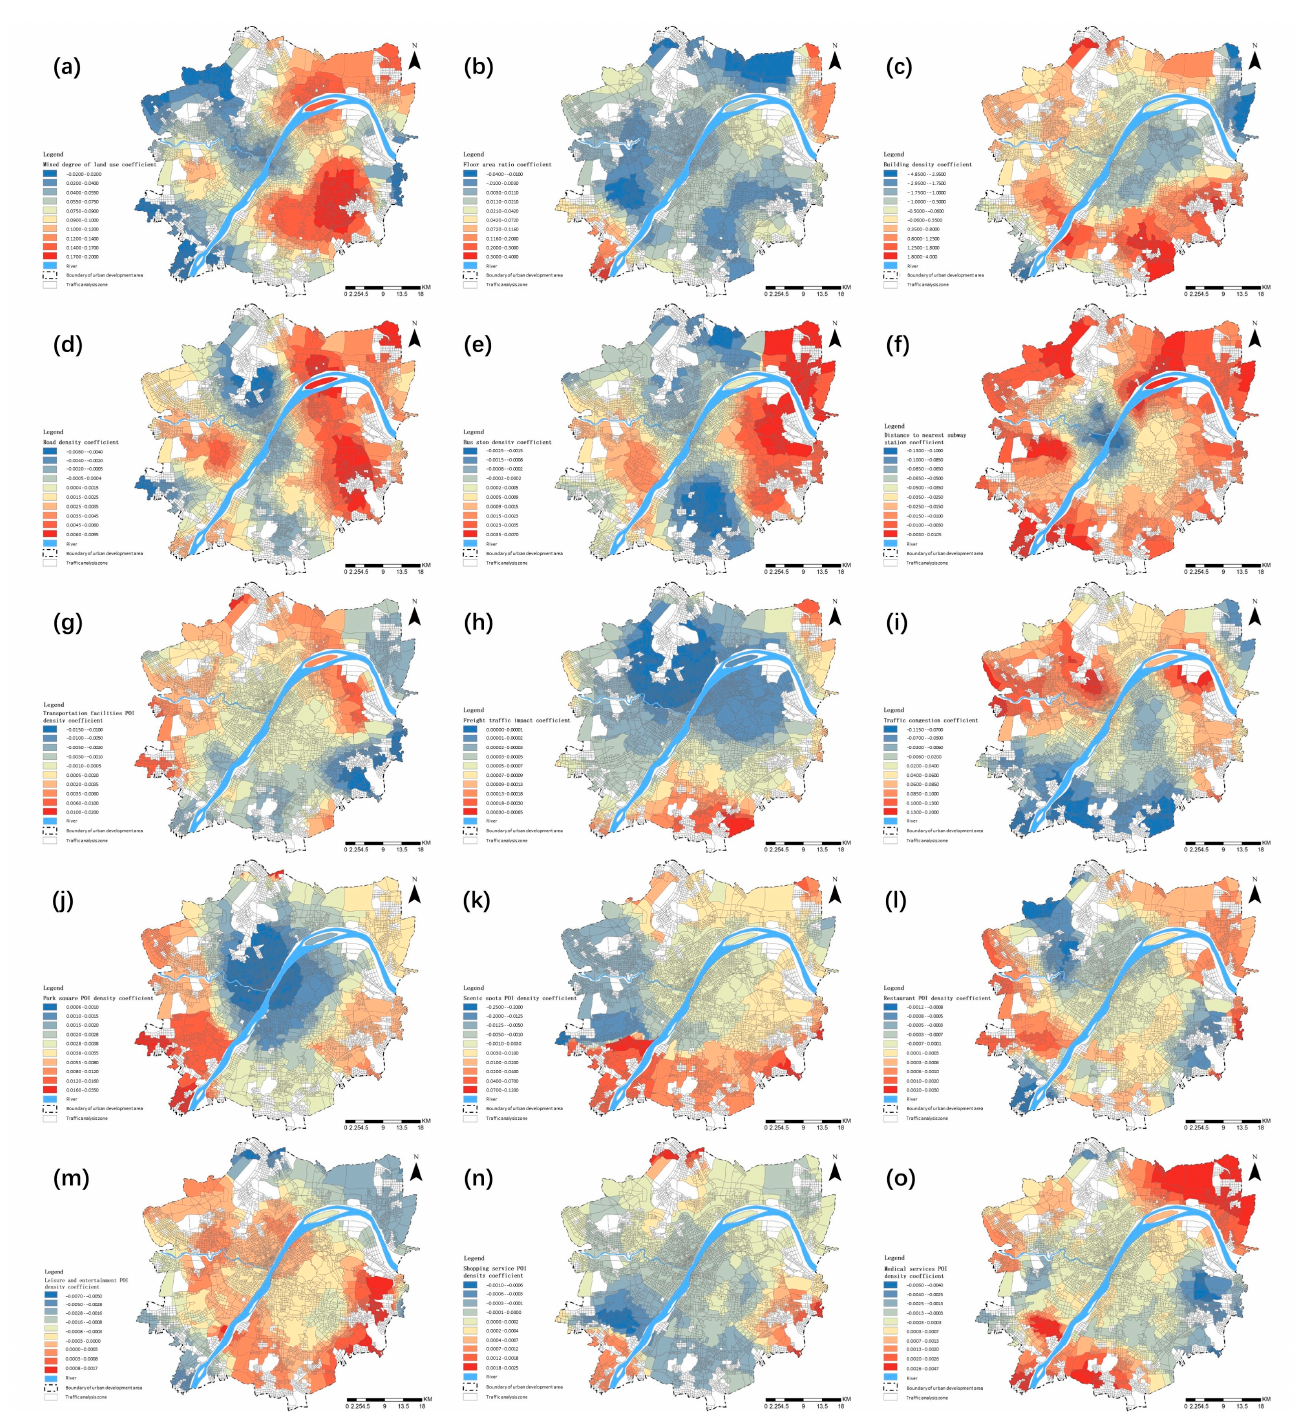
Figure 14. GWR coefficients: ( a – o ) Representing the GWR coefficients between different built environment elements and emotions.